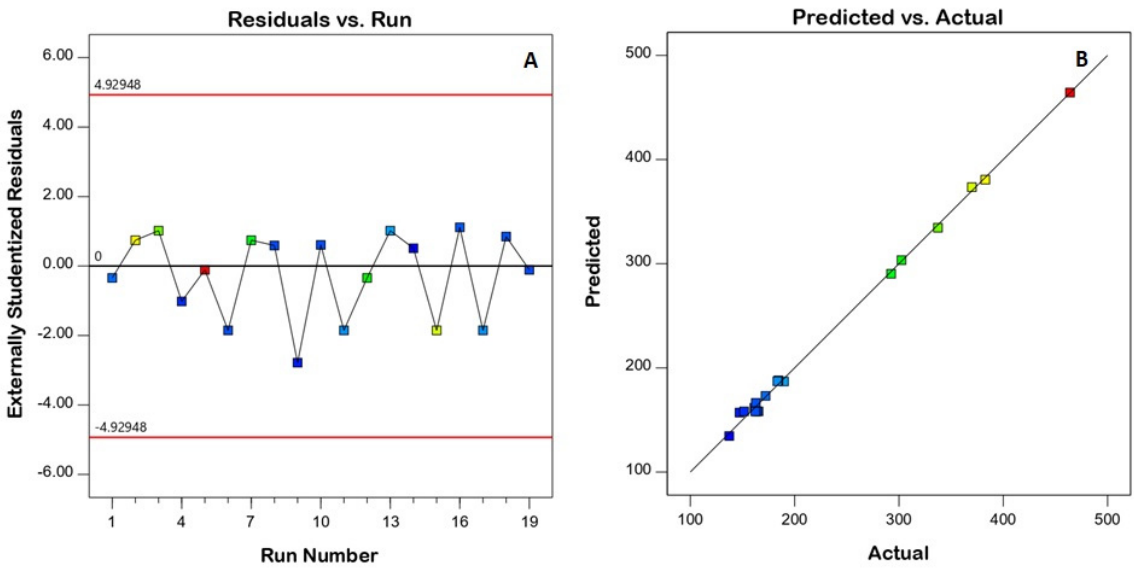
Figure 1. Diagnostic plots for the quadratic models for the droplet size of resveratrol nanoemulsions ( A ) residuals versus the run, ( B ) predicted versus actual values. ( A ) residuals versus the run, ( B ) predicted versus actual